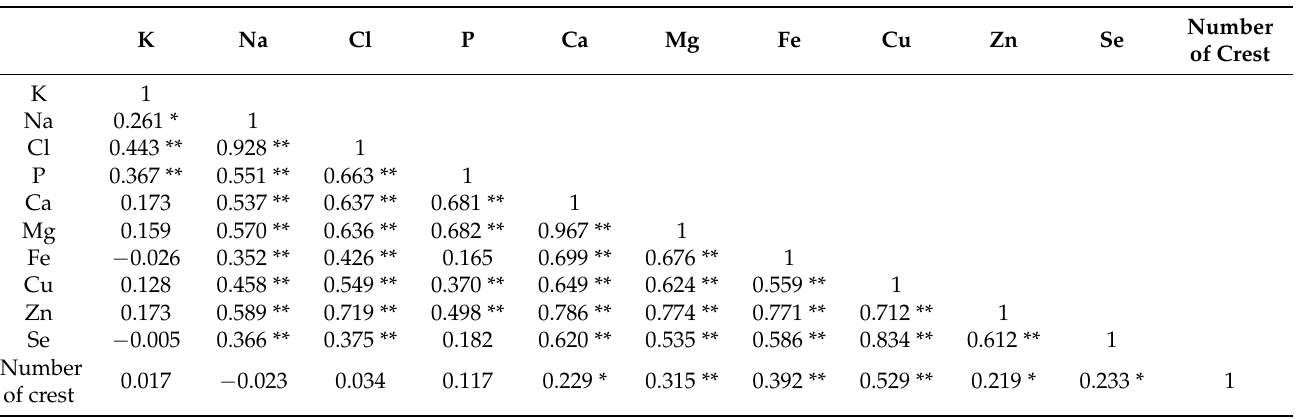
Table 5. Correlation analysis of crested-cushion number with macroelements, trace elements, and mineral